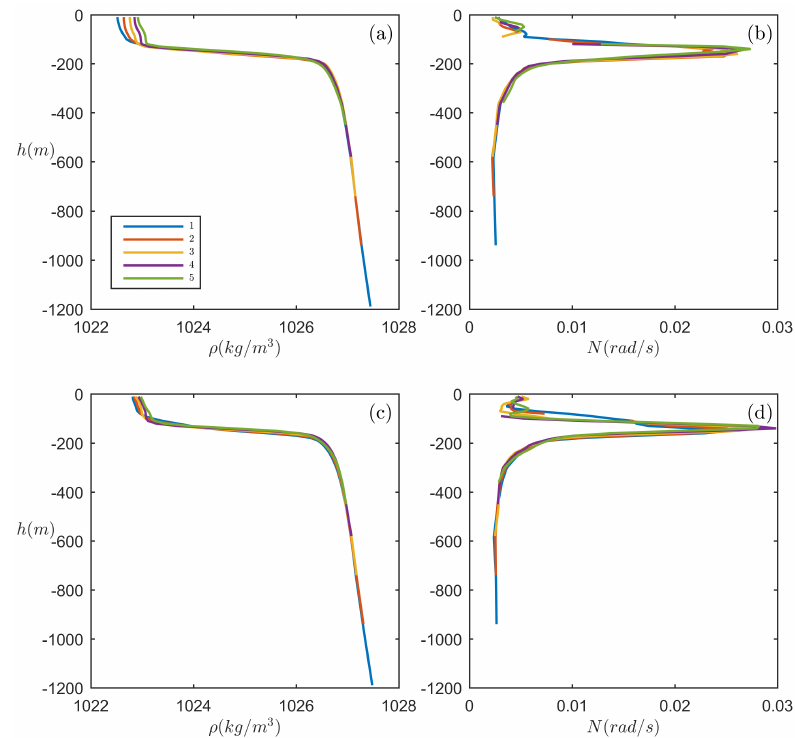
Figure 14. Background density and buoyancy frequency distribution along the transect of the Amazon River Mouth case. ( a , b ) are situations in summer, while ( c , d ) are in winter. Five different lines in each panel represent situations on the chosen five points along the wave propagation